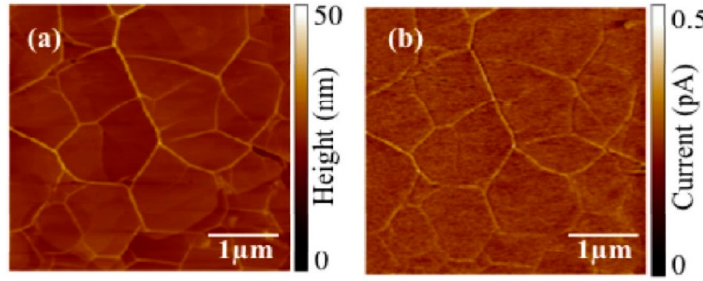
Figure 23. TR morphology ( a ) and current map ( b ) collected on an on-axis sample [124].